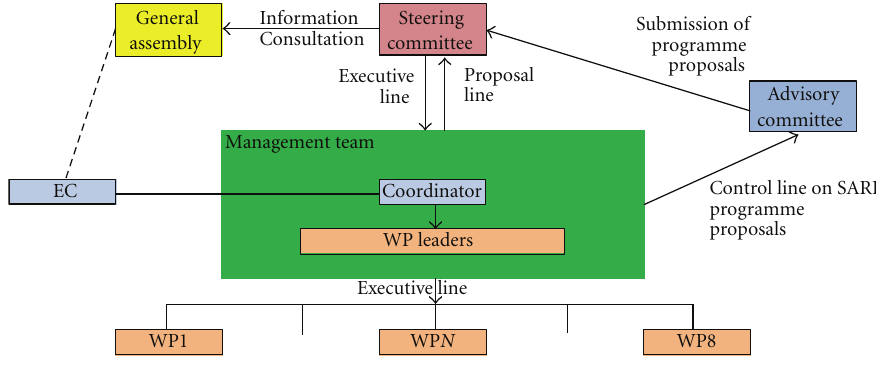
Figure 1: Structure of the SARNET